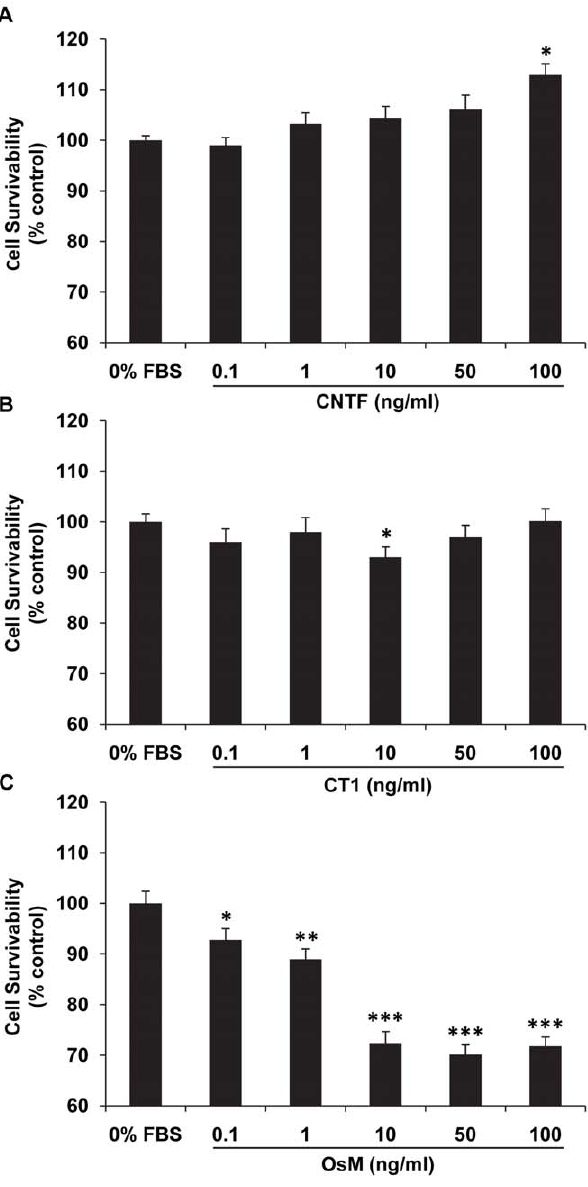
Figure 8. Dose responses of CNTF, CT1 and OsM effects on hfRPE survivability. CNTF showed significant protection on RPE cell survivability while OsM significantly decreased RPE cell survivability at concentrations starting from 0.1 ng/ml. (Summary data from experiments using cells from different donors; * P , 0.05, ** P , 0.01 *** P , 0.001 compared to 0% FBS negative